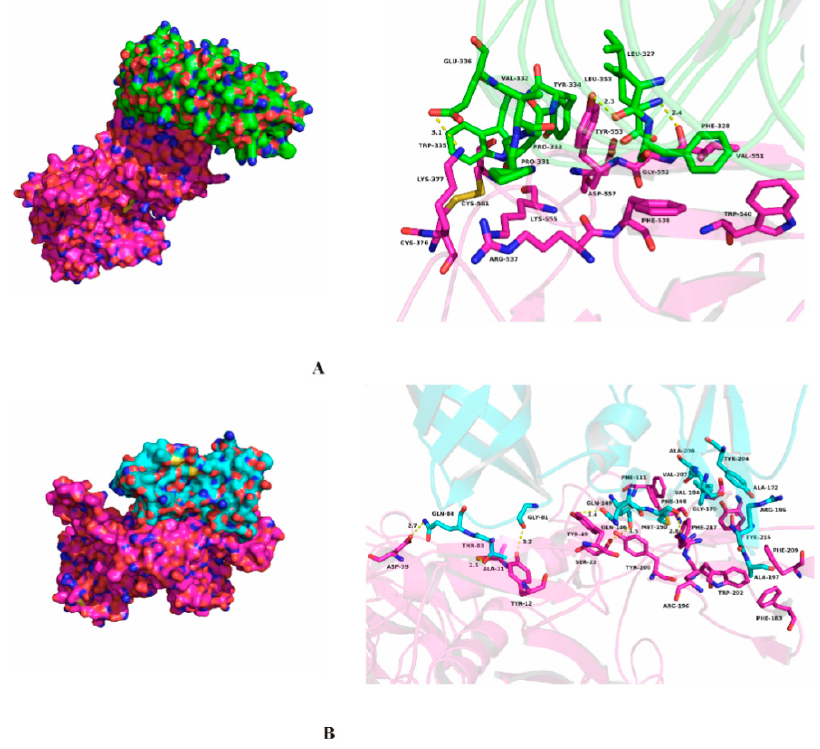
Figure 4. Molecular dockings of aNtMMP-9 and other proteins. ( A ) Molecular docking of aNtMMP-9 (rose red) interacted with DCN (green); and ( B ) molecular docking of aNtMMP-9 (rose red) interacted with TIMP-2 (cyan).